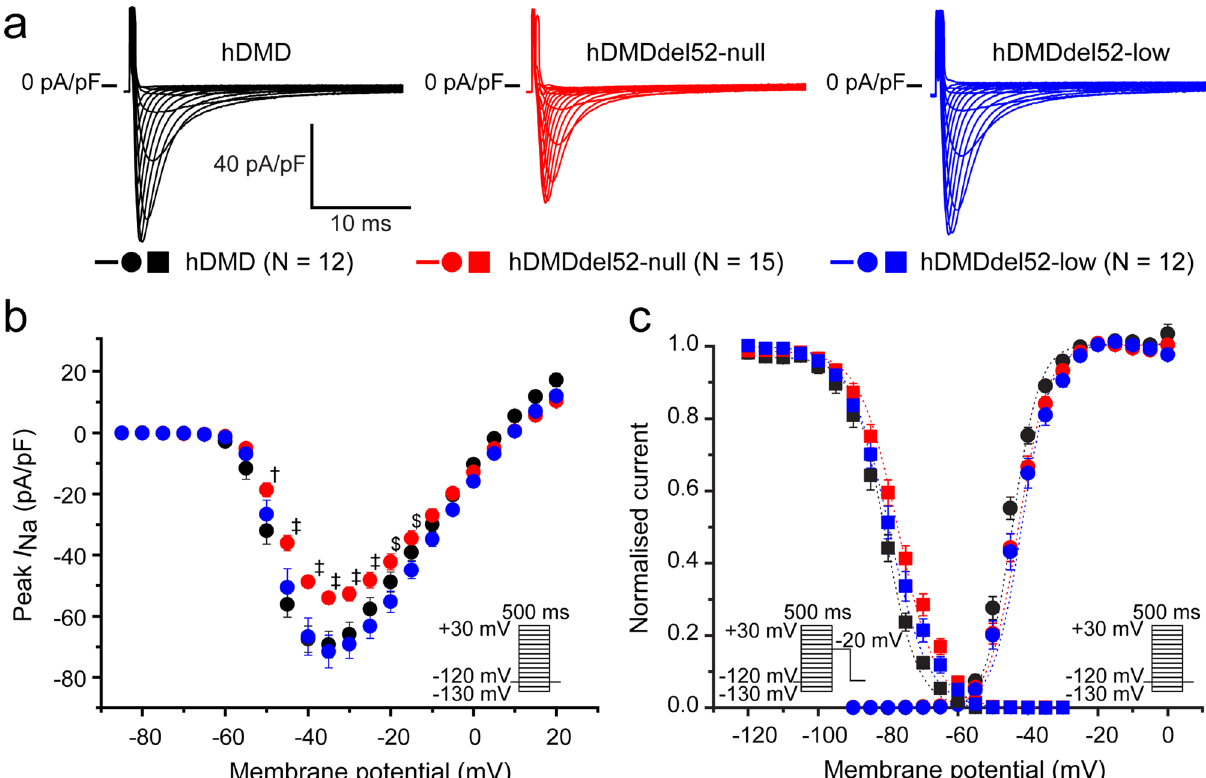
Figure 4. Sodium current ( I Na ) is reduced in dystrophin-null cardiomyocytes, which is prevented by low dystrophin levels. ( a ) Representative peak I Na traces recorded in freshly isolated left ventricular cardiomyocytes from young hDMD (2.53 ± 0.03 months), hDMDdel52-null (2.40 ± 0.04 months), and hDMDdel52-low (2.43 ± 0.09 months). ( b ) Average I Na current–voltage relationship, inset shows voltage-clamp protocol. ( c ) Voltage dependence of activation (circles) and inactivation (squares), dotted lines are Boltzmann fits. Curve of inactivation was shifted in hDMDdel52-null (see Table 1). Inset shows voltage-clamp protocol, N represents the number of cardiomyocytes measured. Cardiomyocytes were isolated from 3 hDMD, 4 hDMDdel52-null, and 3 hDMDdel52-low mice. † P < 0.05 for hDMDdel52-null vs. hDMD, ‡ P < 0.05 hDMDdel52-null vs. hDMD and